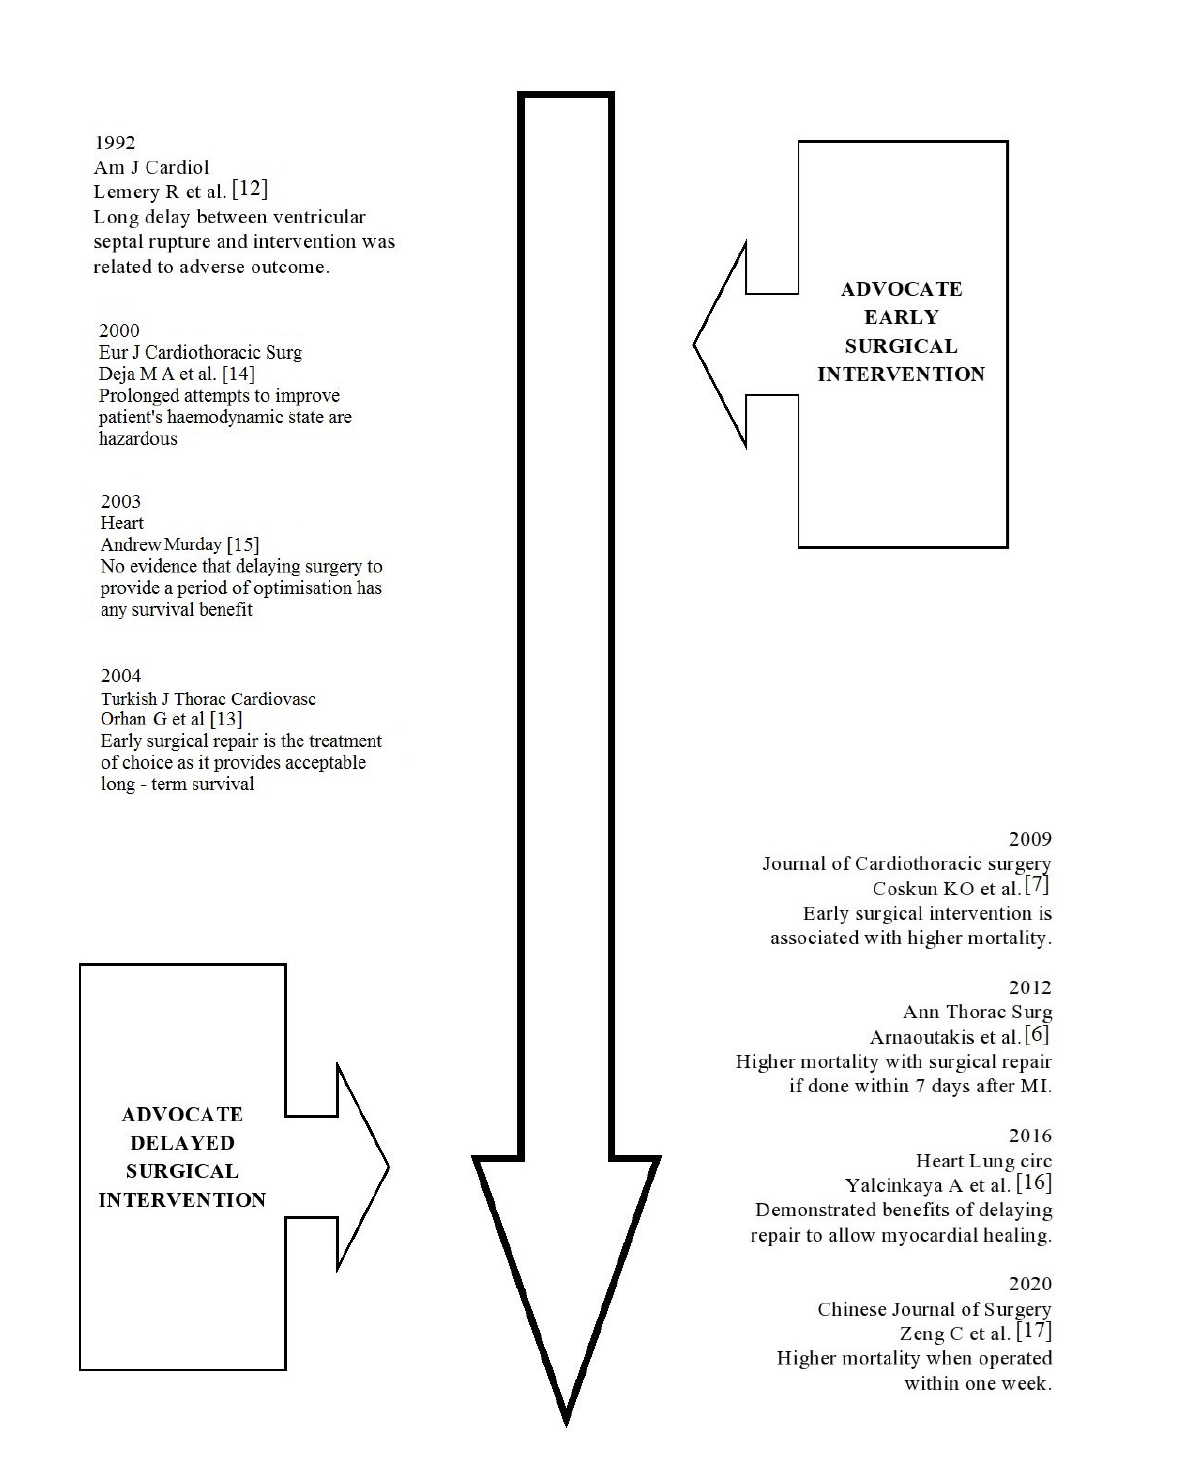
Fig. 1 – Timeline of various studies and their inference. MI=myocardial